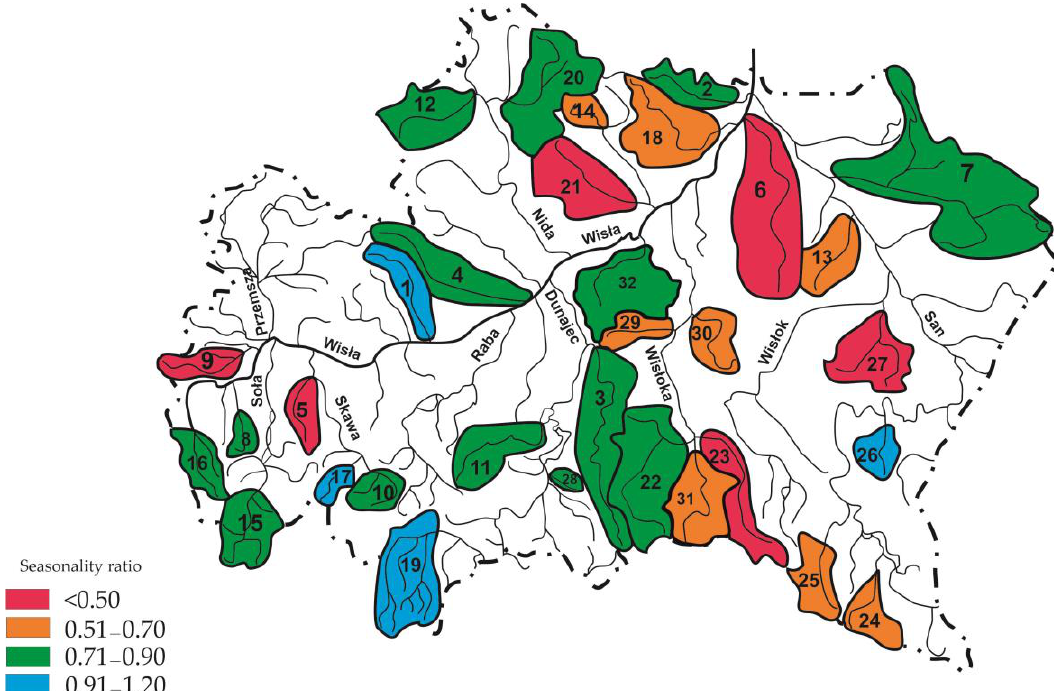
Figure 3. Seasonality ratio (SR) for summer and winter low flow discharge for analyzed catch- ments.